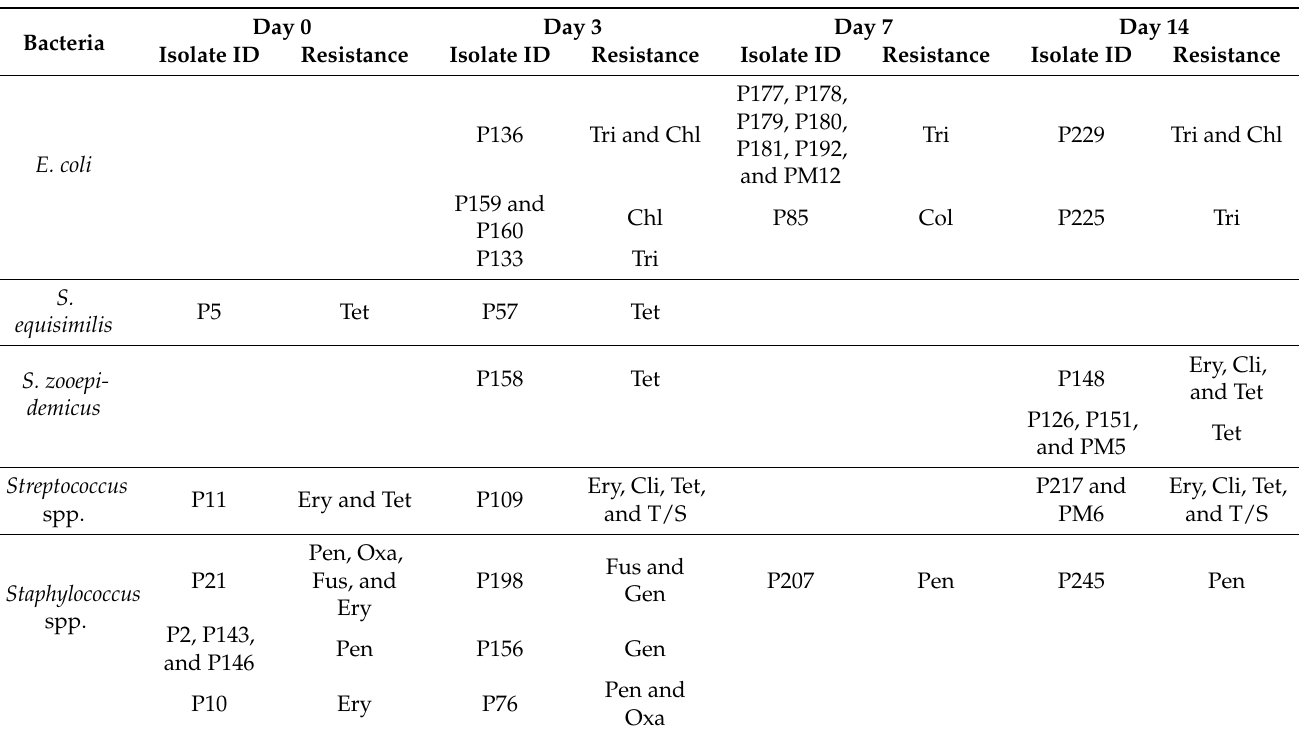
Table 7. Antimicrobial resistance of bacteria isolates from the vagina of 10 mares before and after